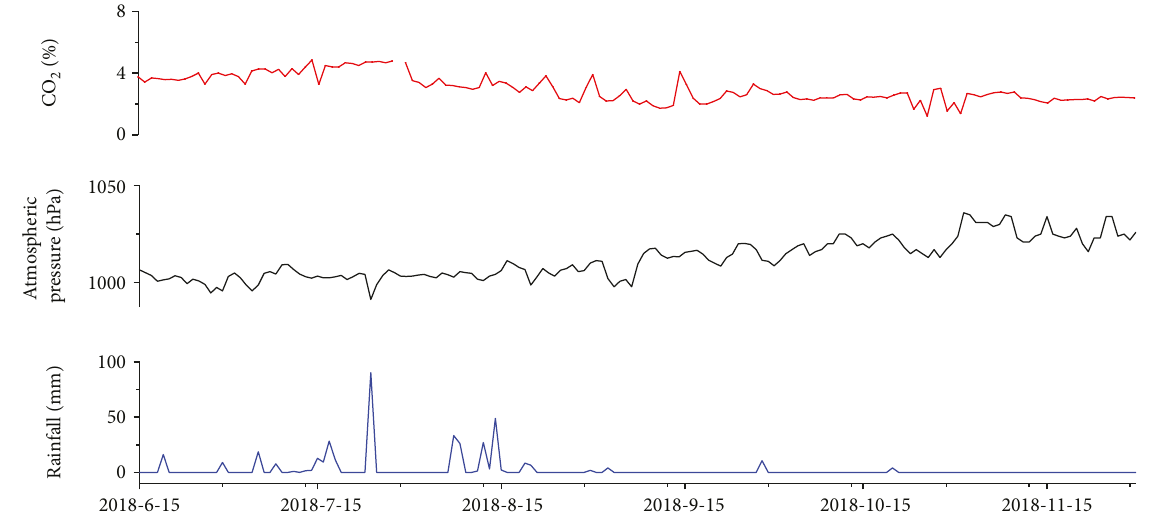
Figure 14: CO concentrations in soil gas from the TJYC well, atmospheric pressure, and local 2